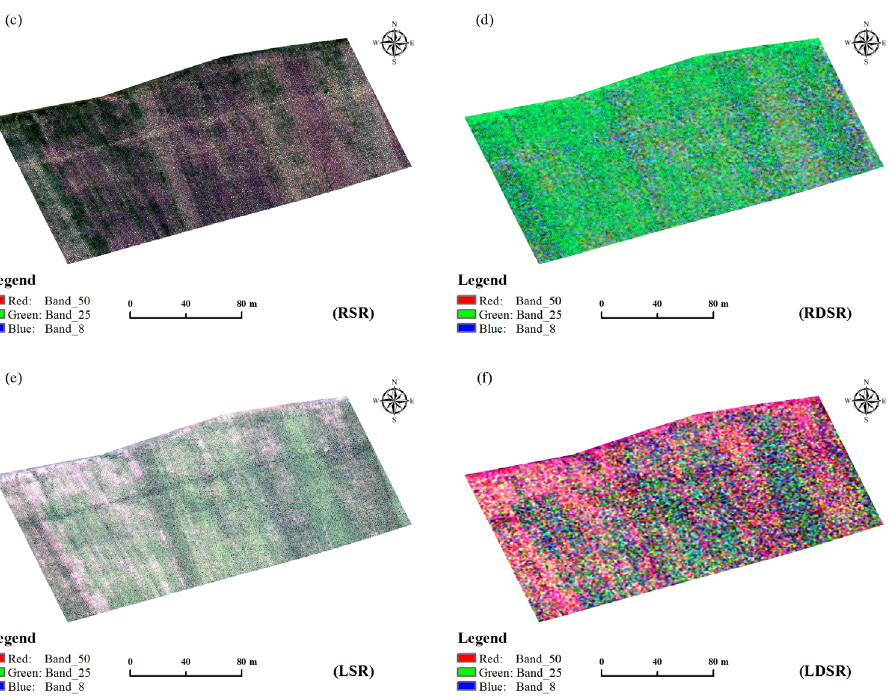
Figure 4. Images of six spectral transformations of the original hyperspectral image of the UAV on July 30: ( a ) SSR, ( b ) DSR, ( c ) RSR, ( d ) RDSR, ( e ) LSR, ( f ) LDSR.